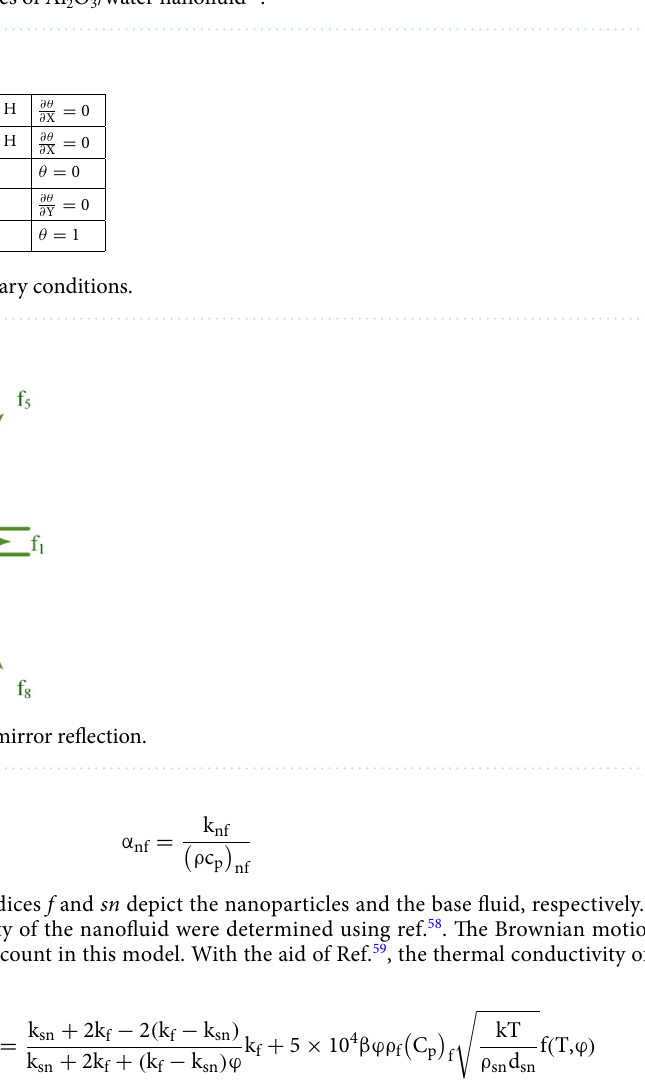
Table 1. Thermophysical properties of Al 2 O 3 /water nanofluid 23 .